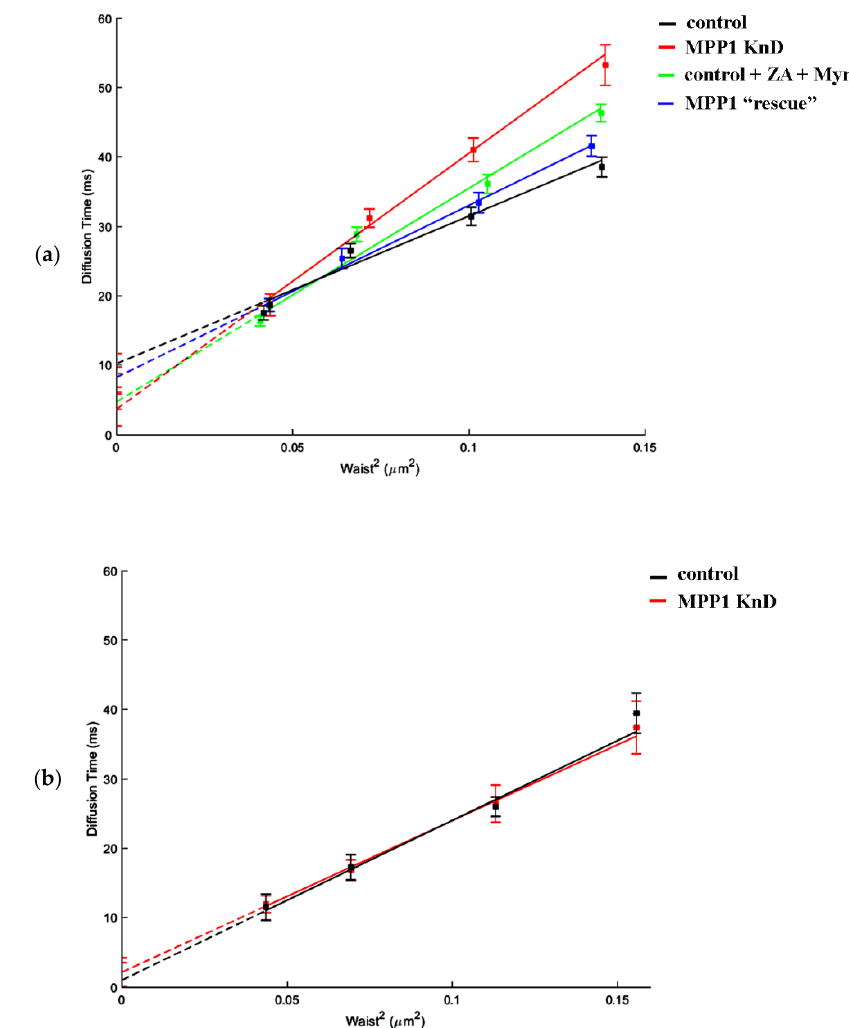
Figure 3. The switchable impact of MPP1 on the molecular mobility and confinement of SM in raft nanodomains. svFCS measurements and representative diffusion laws for ( a ) fluorescently labeled sphingomyelin (SM-BODIPY) and ( b ) phosphatidylcholine (PC-BODIPY) in HEL cells.